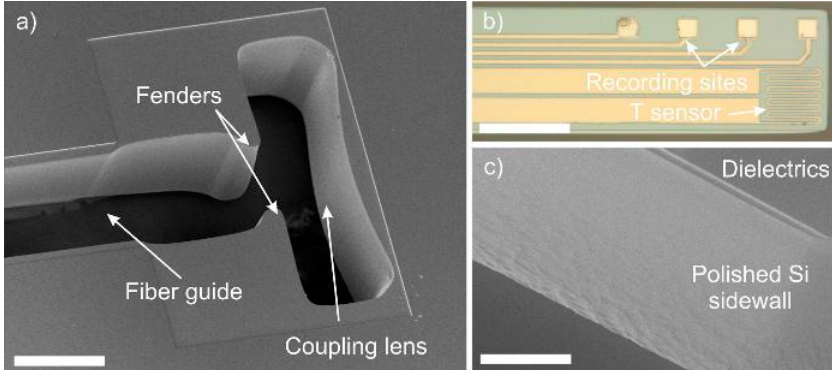
Figure 1. Close SEM view of the coupling region on the chip ( a ). Tip of a fully functional optrode ( b ). Close microscopy ( b ) and representative SEM view of the shaft polished sidewall ( c ). Scale bar shows 100 microns on all figures.